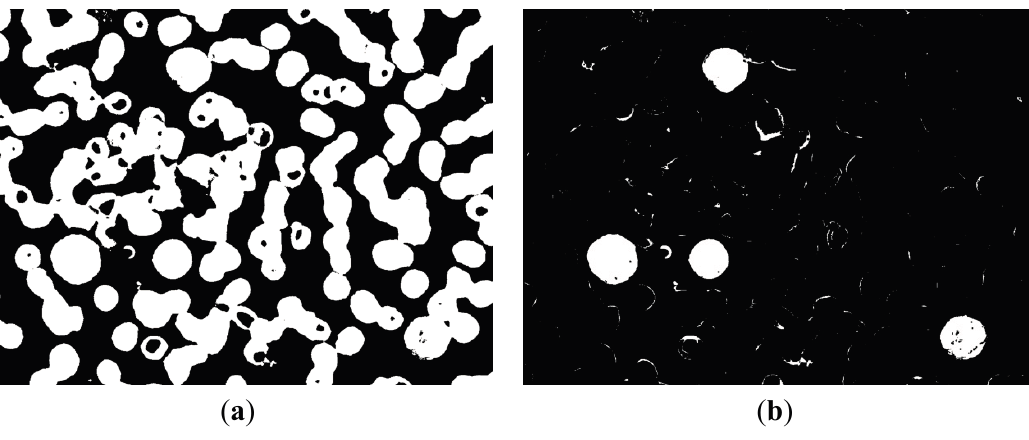
Figure 11. ( a ) Result of the whole segmentation of the WBC and RBC regions; ( b ) Preliminary result of the entire WBC region segmentation.